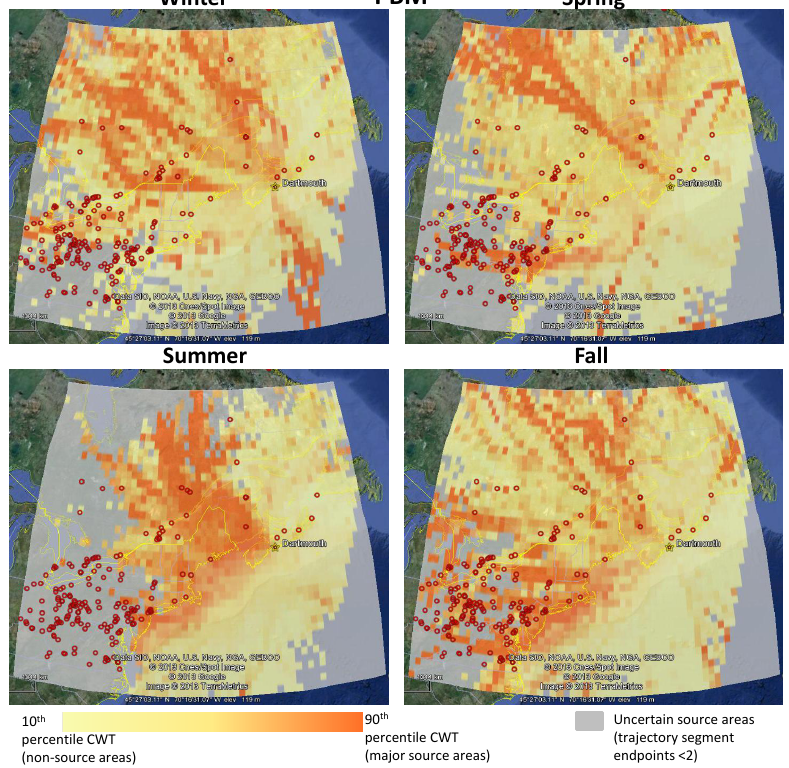
Fig. 6. Same as Fig. 4 except for